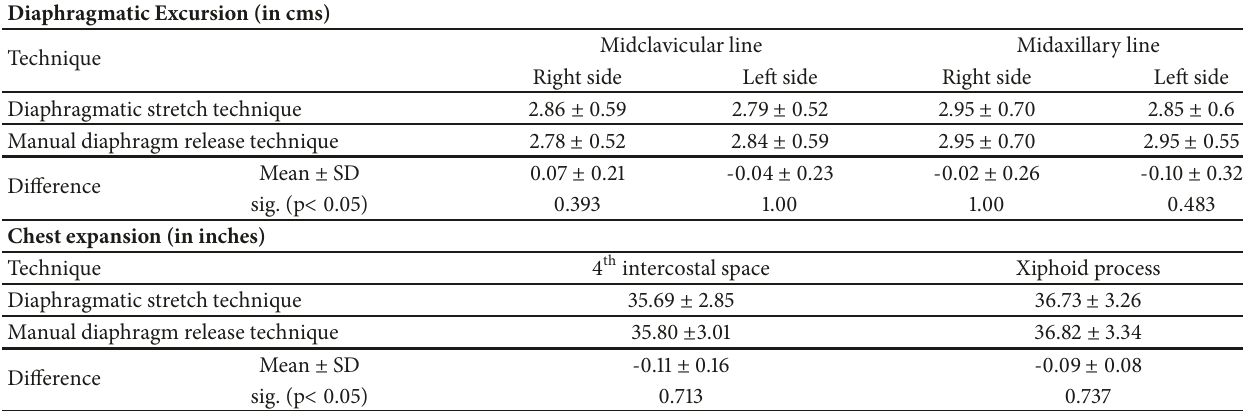
Table 5: Comparison of post intervention values of Diaphragmatic Excursion and Chest Expansion between groups. Diaphragmatic Excursion (in cms) Technique Diaphragmatic stretch